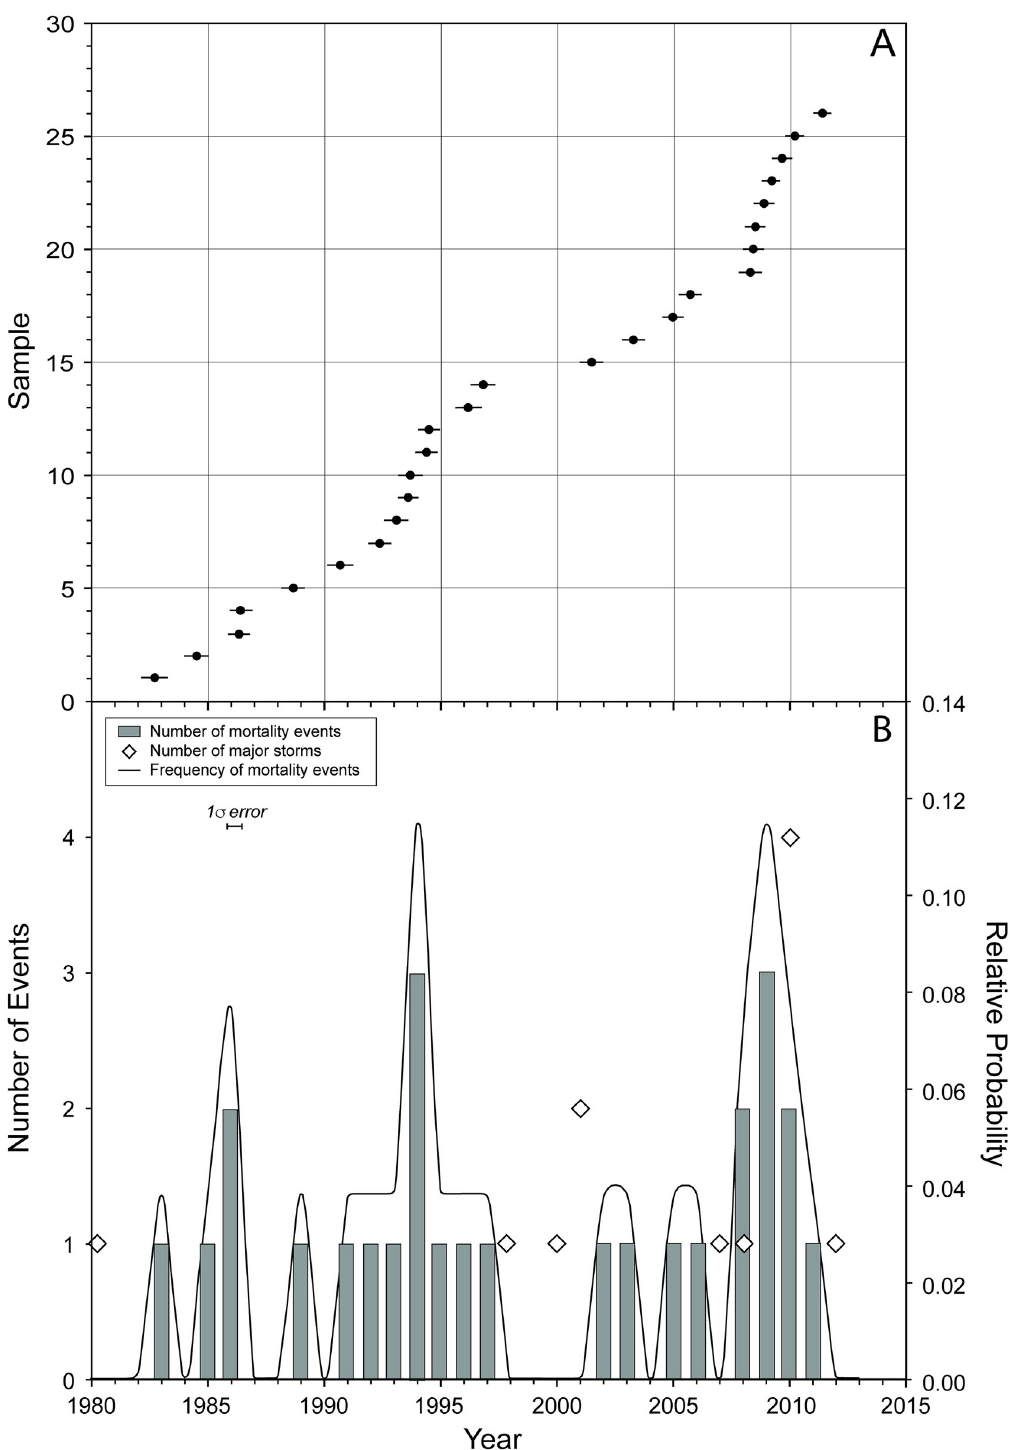
Fig 6. Acropora cervicornis 230 Th mortality events and known storms. (A) Acropora cervicornis 230 Th ages ( ± 1 σ error bars) determined from 26 coral fragments collected from the substrate of transect T5 and excavated proximal to the transect. In this plot, significant mortality events would be indicated by several samples with the same or similar ages (e.g., forming a horizontal array); (B) Histogram and relative probability curve of Acropora cervicornis 230 Th mortality events. The relative probability curve (black) shows peaks in coral mortality centered at 1986, 1994, and 2009. Diamonds indicate number of known tropical storms and hurricanes in proximity of Coral Gardens in a given year. https://doi.org/10.1371/journal.pone.0280852.g006 PLOS ONE | https://doi.org/10.1371/journal.pone.0280852 February 8,